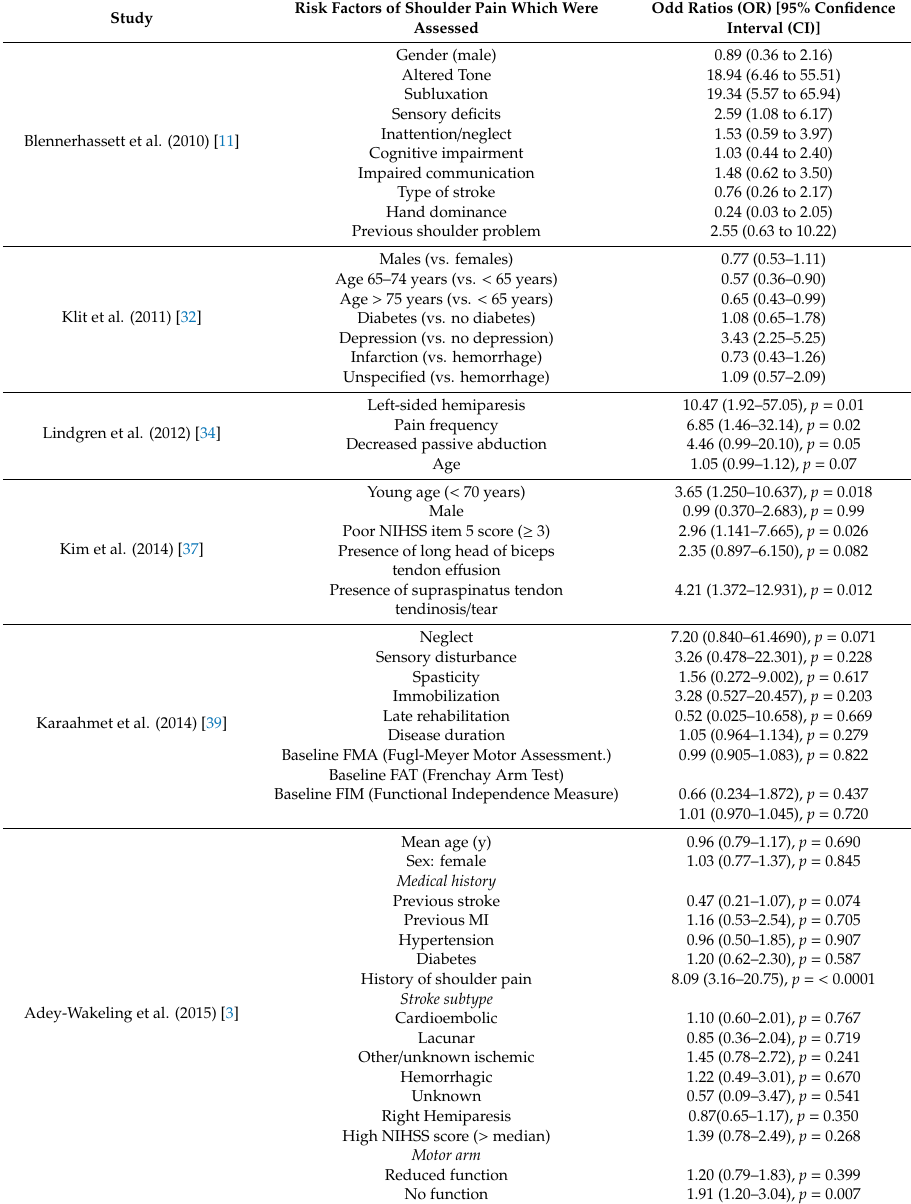
Table 5. Shoulder pain and risk factors used in the included